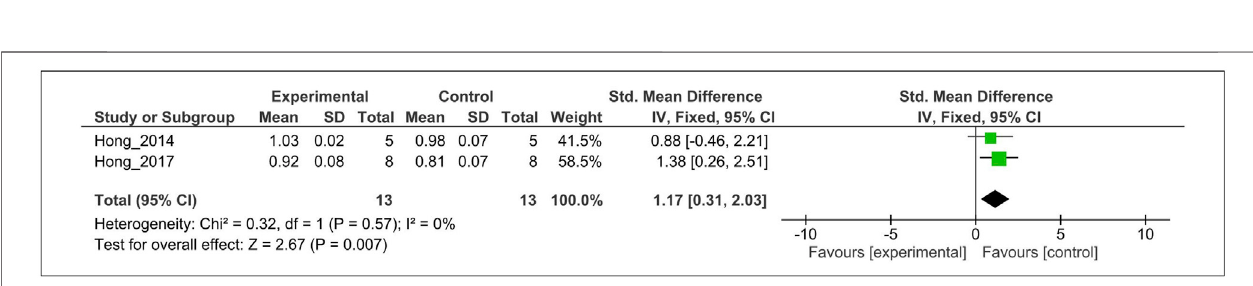
FIGURE4| ForestplotshowingtheeffectsofMTonTGF- β 1levels.MT,melatonin;TGF- β 1,transforminggrowthfactor- β 1;CI,con fi denceinterval;IV,independent